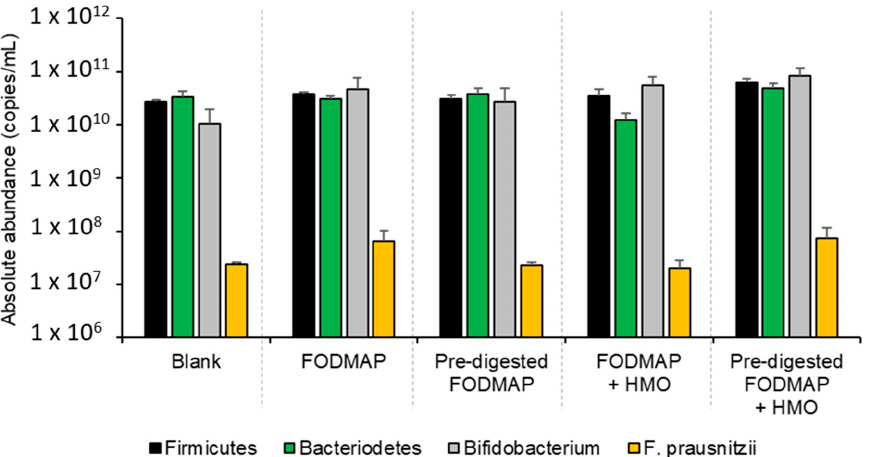
Figure 4. Absolute abundance of Firmicutes, Bacteroidetes, Bifidobacterium , and Faecalibacterium prausnitzii in short-term colonic batch experiments (48 h). Average ± SEM is shown across donors. The test substrates were as follows: FODMAP (0.86 g/L FOS + 0.21 g/L stachyose + 0.21 g/L raffinose + 1.71 g/L lactose), pre-digested FODMAP (0.05 g/L stachyose + 0.10 g/L raffinose + 0.11 g/L lactose), FODMAP + HMO (FODMAP composition + 2.4 g/L 2 ′ FL/DFL + 0.6 g/L lacto-N-neotetraose), pre- digested FODMAP + HMO (pre-digested FODMAP composition + 2.4 g/L 2 ′ FL/DFL + 0.6 g/L lacto- N-neotetraose). 2 ′ FL = 2 ′ fucosyllactose; DFL = difucosyllactose; FODMAP = fermentable oligosac- charides, disaccharides, monosaccharides, and polyols; HMO = human milk oligosaccharide.